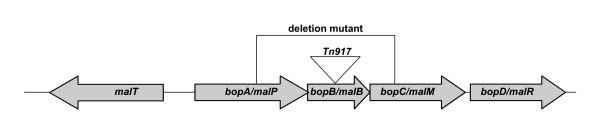
Schematic representation of the Bop locus (modified from 8 and 10).